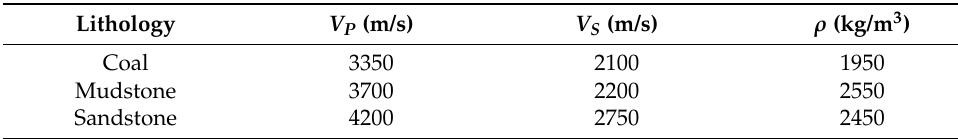
Table 1. Elastic parameters of the theoretical